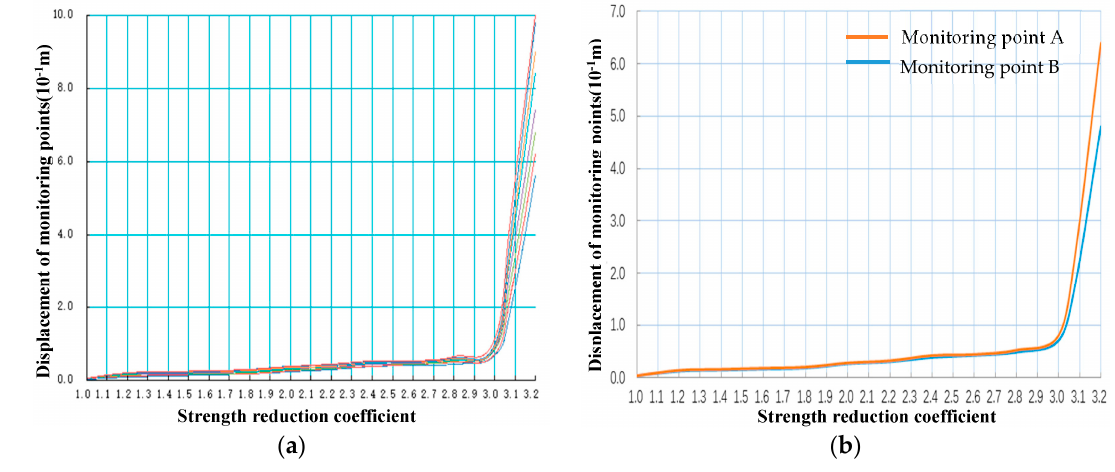
Figure 7. ( a ) Deformation curve of dam monitoring points (Examples monitoring points in Figure 5a); ( b ) Deformation curve of dam monitoring point A, B (UG7).